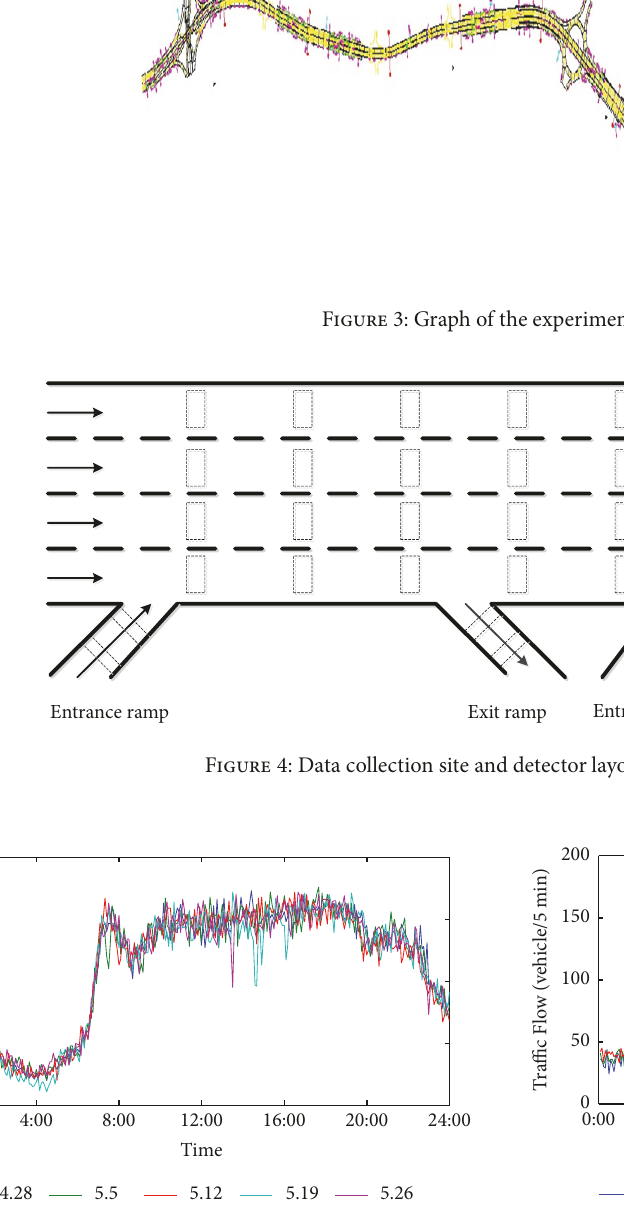
Figure 6:Trafficflowdata of differentdetectionsections in thesame